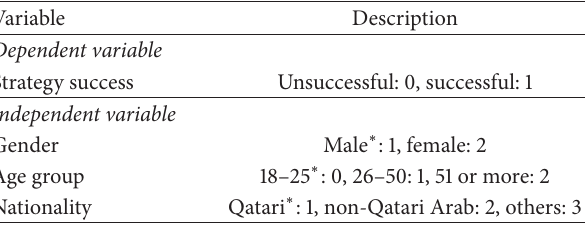
Table 2: Variable coding and